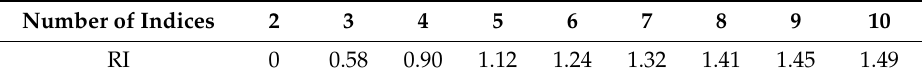
Table 5. The standard values of the ratio index [30].